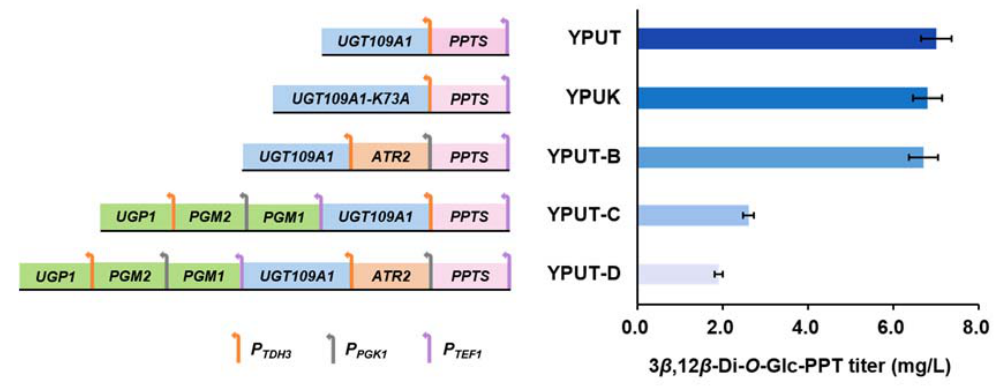
Figure 3. Production of 3 β ,12 β -Di- O -Glc-PPT in the engineered strains. The gene in pink box is derived from P. ginseng . The gene in orange box is derived from A. thaliana . The gene in blue box is derived from B. subtilis . The genes in green boxes are derived from S. cerevisiae .